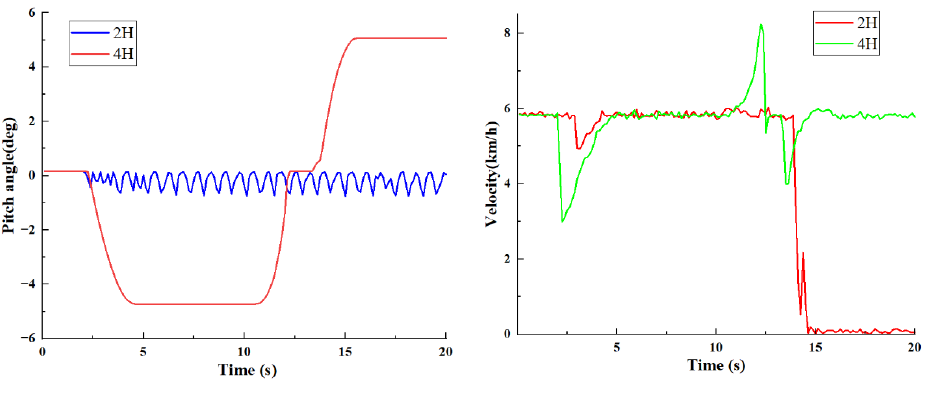
Figure 15. Results of the ridge crossing test.